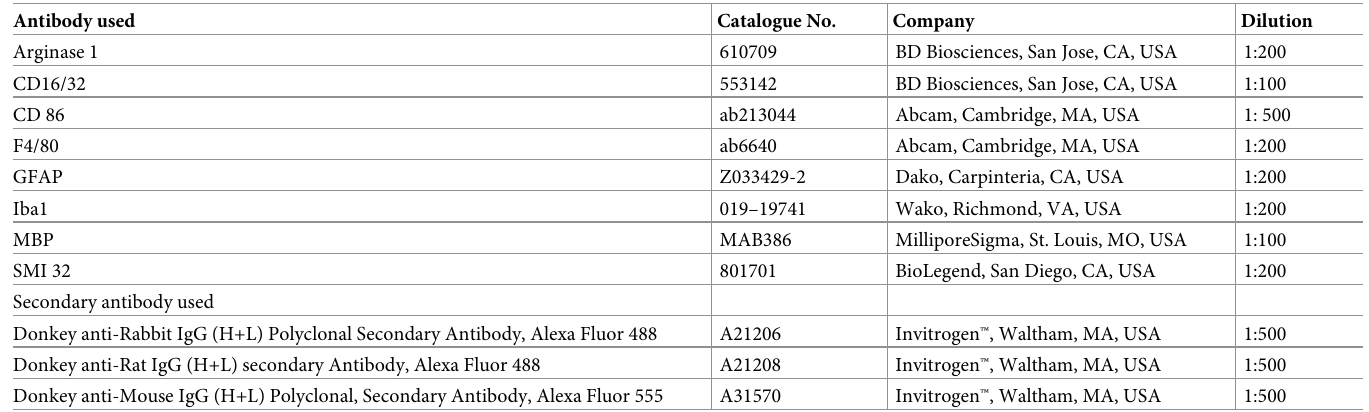
Table 1. Details of primary and secondary antibodies